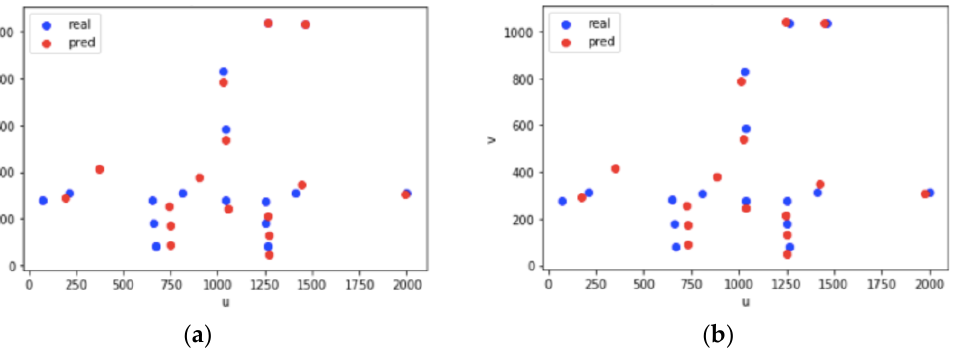
Figure 13. Projection results for scene B: ( a ) projection results before optimization; ( b ) optimized projection results.